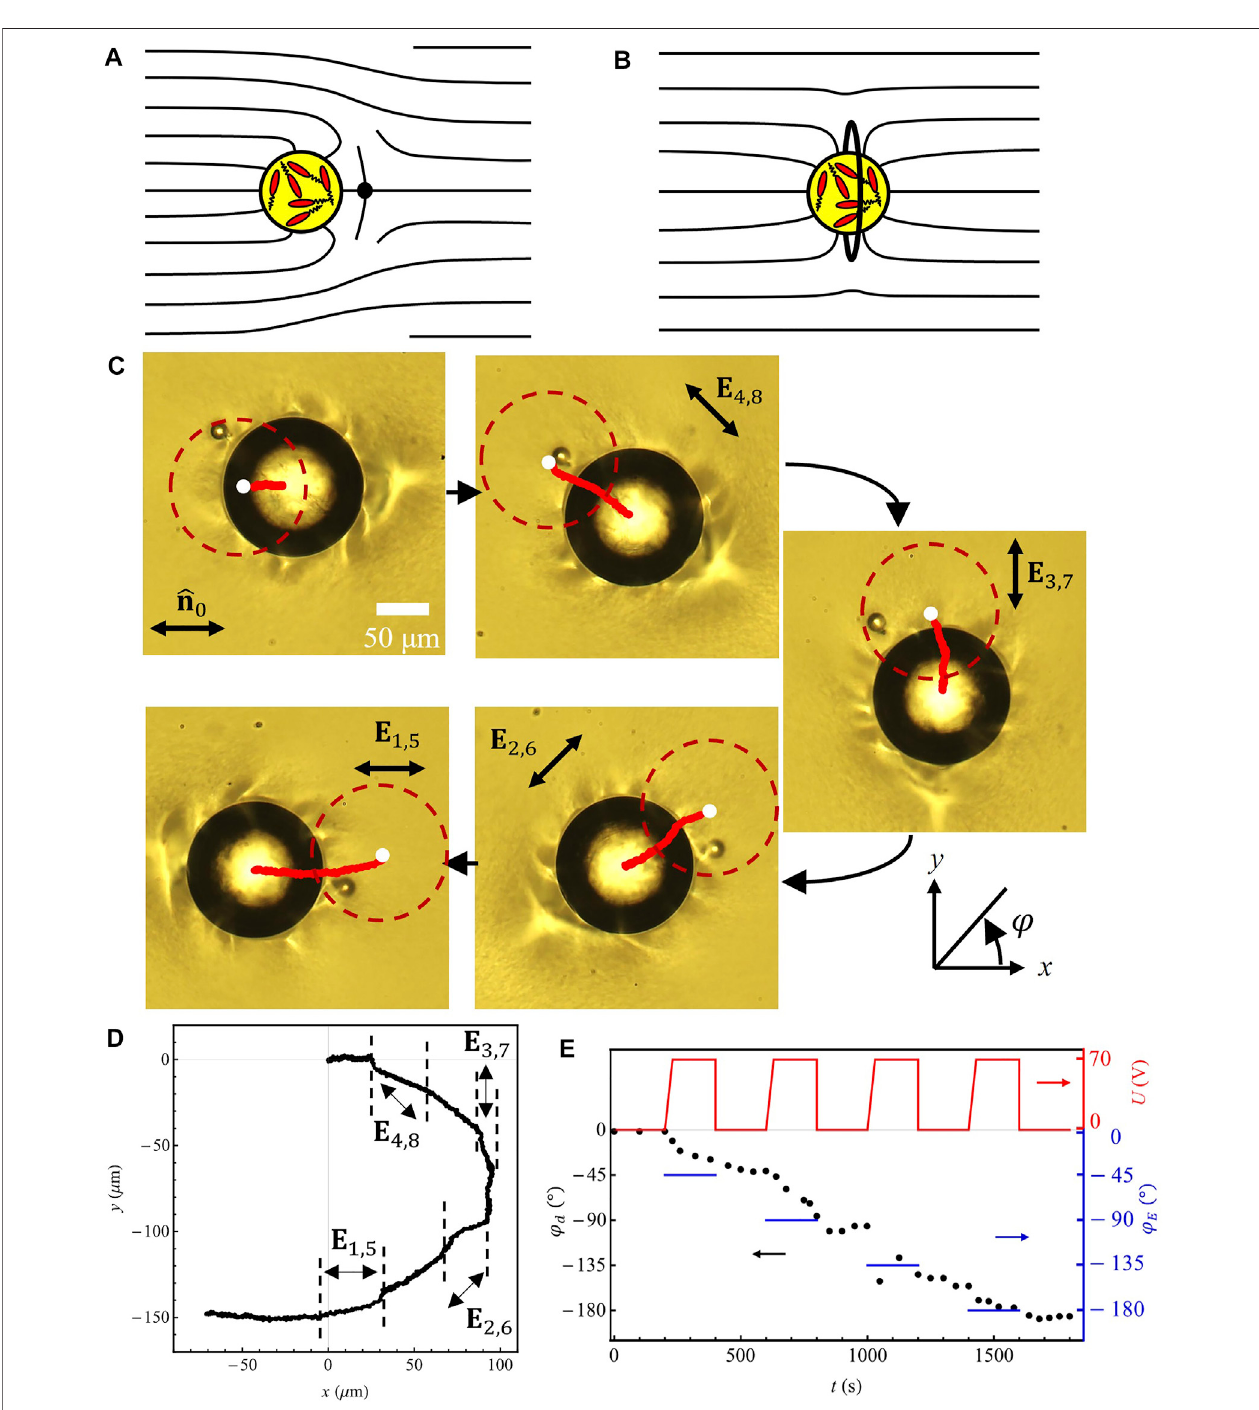
FIGURE 2 | Electric fi eld control of propulsion direction of active droplets in the nematic 5CB. Director con fi guration around a sphere with perpendicular surface anchoring that produces (A) a point-defect hyperbolic hedgehog or (B) a Saturn ring. (C) The sequence of images shows the trajectory of the active droplet. E i , j means theelectric fi eldisappliedthroughtheelectrodes i and j .Thewhitedisksshowthestartingpointsoftheredtrajectories,andtheredopencirclesoutlinethedropletatthe startingpoints. U (cid:2) 70V , f (cid:2) 200kHz. (D) In-plane trajectory ofanactive dropletredirected bythe fi eld. (E) The voltage amplitude (solid line), theangle φ d between the propulsion direction and the x -axis ( fi lled circles), and the angle φ E between the fi eld and the x -axis (horizontal dashes), all as functions of time.